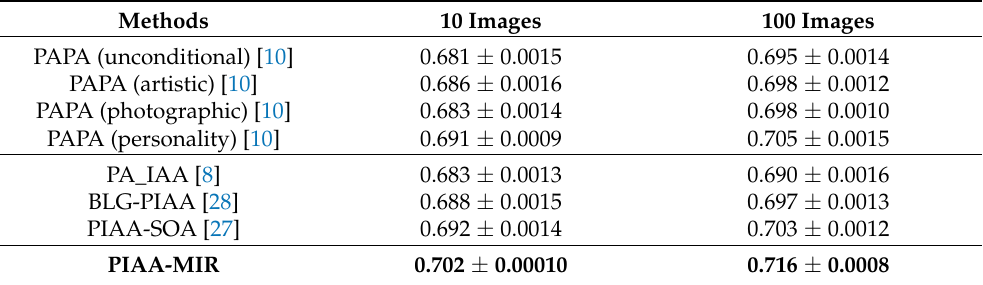
Table 1. SROCC results of our PIAA-MIR with several PIAA methods on the PAPA database [10]. PAPA (unconditional) indicates the unconditional PIAA model proposed by the authors of PAPA. Similarly, PAPA (artistic), PAPA (photographic), and PAPA (photographic) denote the PIAA model by embedding three types of conditional information (artistic experience, photographic experience, and personality traits).